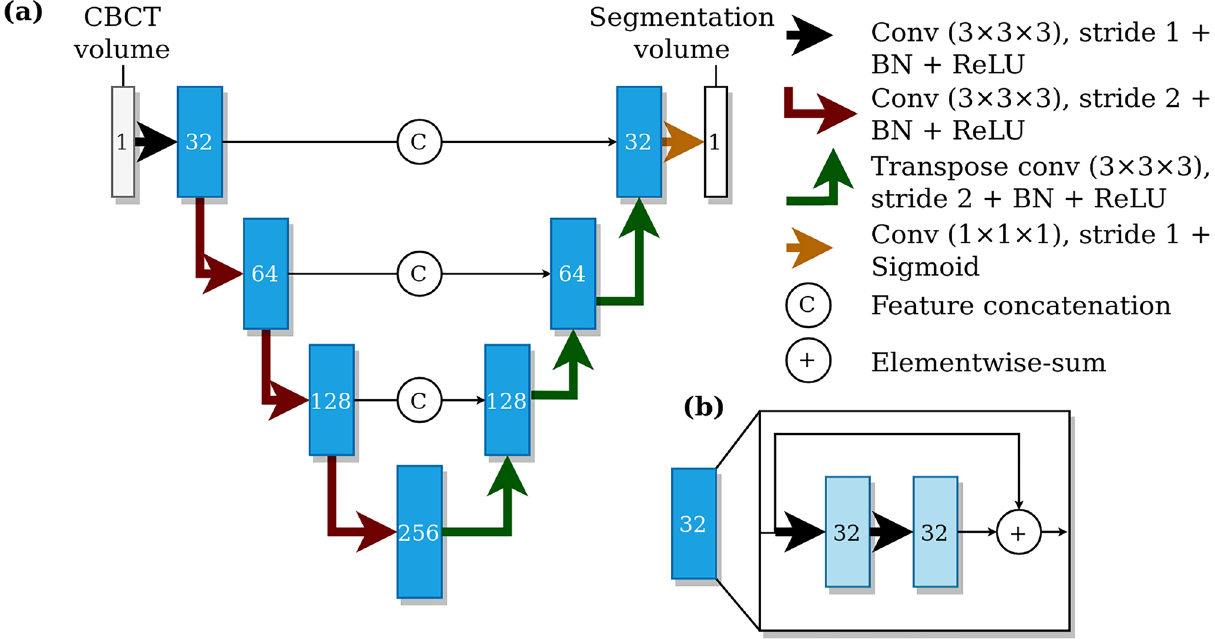
Figure 2. The architecture of the deep learning system. ( a ) A U-net style deep learning system architecture with a contracting pathway and an expanding pathway. The contracting pathway is visualised with red arrows, each marking a convolution block with a stride of two. The expanding pathway is visualised with green arrows, each marking a transpose convolution block with a stride of two. The pathways are connected with feature concatenation marked using arrows with the letter C. The number of feature maps is shown on each block and all the convolutions except the last one have a kernel size of 3 × 3 × 3. The last convolution has one feature, a kernel size of 1 × 1 × 1, no layer normalisation, and uses the sigmoid nonlinearity. ( b ) Each block includes two convolutions with a stride of one, batch normalisation (BN), and ReLU non-linearities with elementwise summation marked using arrows with a plus